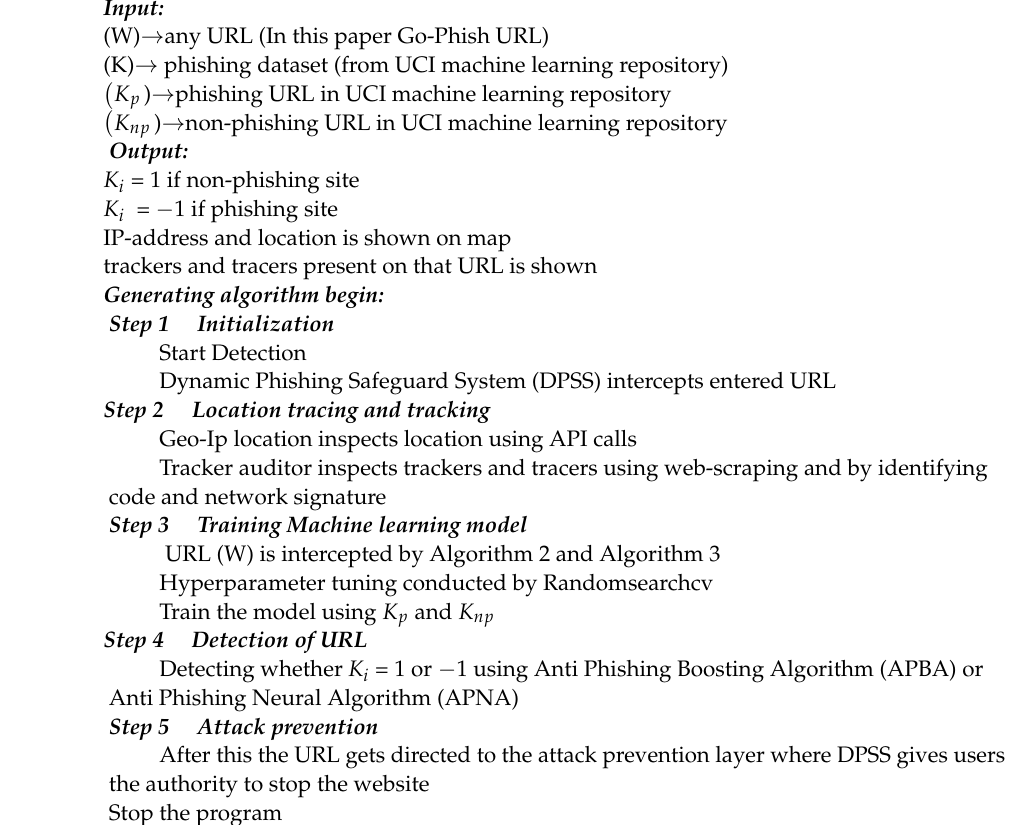
Algorithm 1: Neural Boost Phishing Protection